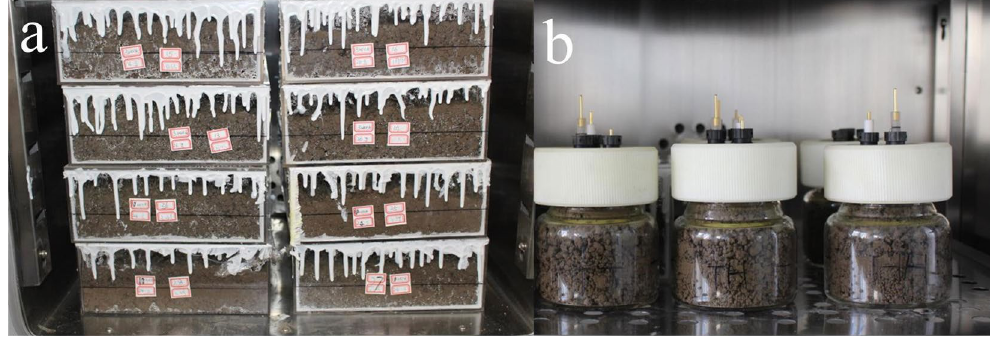
Figure 1. ( a ) The labeled soil reactors filled with soil samples burying coupons; ( b ) the electrochemical cell filled with soil